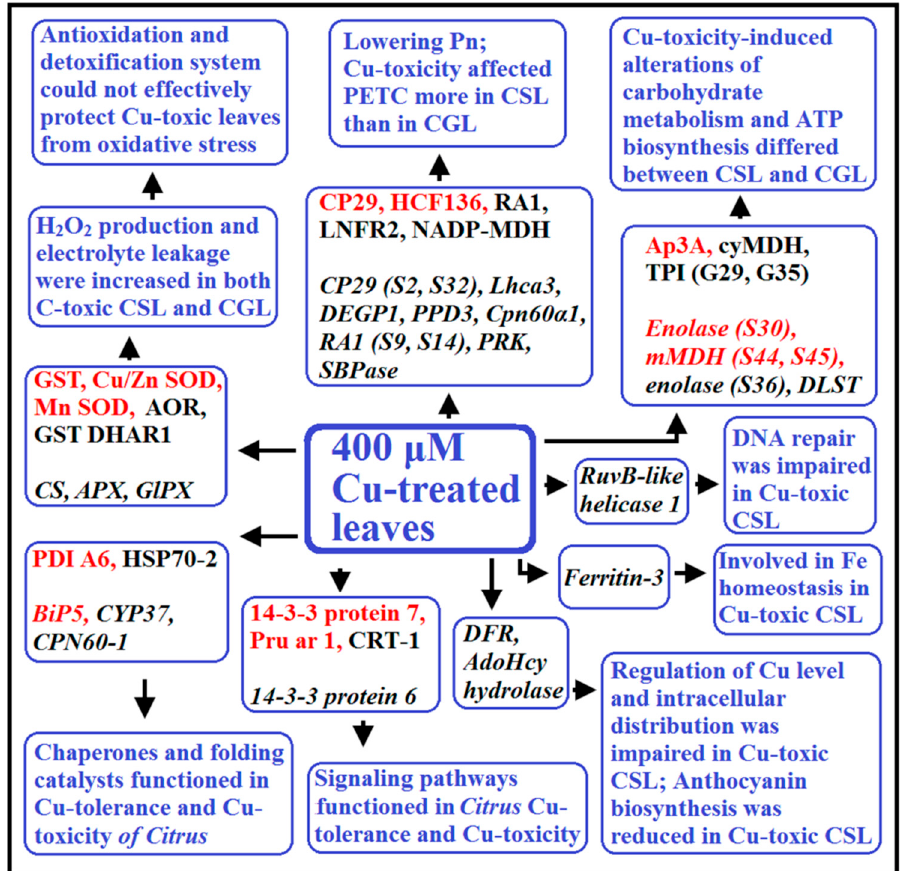
Figure 5. A possible model displaying the di ff erentially abundant proteins (DAPs) in 400 µ M Cu-treated Citrus grandis leaves (CGL) and Citrus sinensis leaves (CSL). In this Figure, plain format and italics were used for Cu-toxic CGL and CSL, respectively. Red: DAPs increased in abundance; Black: DAPs decreased in abundances; APX, L-ascorbate peroxidase; DLST: dihydrolipoyllysine-residue succinyltransferase component of 2-oxoglutarate dehydrogenase complex 2; GlPX: glutathione peroxidase; Pn: photosynthesis; RA1: Rubisco activase A1. Supplementary Materials: The following are available online at http: // www.mdpi.com / 2223-7747 / 9 / 3 / 291 / s1, Figure S1: Excess Cu e ff ects on growth of Citrus grandis (A) and Citrus sinensis (B), Figure S2: Excess Cu e ff ects on root (A), stem (B), leaf (C) and whole plant (D) dry weight (DW) in Citrus grandis and Citrus sinensis seedlings, Figure S3: 2-DE images of proteins extracted from 0.5 (A, E, I, M), 200 (B, F, J, N) 300 (C, G, K, O) and 400 (D, H, L, P) Cu-treated Citrus grandis (A-D and I-L) and Citrus sinensis (E-H and M-P) leaves for the other two replicates, Figure S4: Close-up views of 24 DAP spots in 200, 300 and 400 µ M Cu-treated Citrus sinensis and Citrus grandis leaves, Figure S5: Venn diagram analysis of Cu-responsive proteins in Citrus grandis and Citrus sinensis leaves, Figure S6: Significantly enriched (A-E and H) and the most enriched (F-G) KEGG pathways for annotated di ff erentially abundant proteins (DAPs) in Cu-treated Citrus grandis (A-D) and Citrus sinensis (E-H) leaves, Figure S7: Matrices of Pearson correlation coe ffi cients for di ff erentially abundant proteins (DAPs) in Citrus grandis (A) and Citrus sinensis (B) leaves, Figure S8: Relative expression levels of genes encoding 22 di ff erentially abundant proteins (DAPs) identified in 400 µ M Cu-treated Citrus grandis (G3, G9, G10, G11, G14, G26, G29, G33, G34 and G35) and Citrus sinensis (S2, S5, S9, S16, S17, S23, S24, S30, S32, S33, S37 and S43) leaves using PRPF31 (A) and actin (B) as internal standards, Table S1: Master list of proteins identified in MALDI TOF / TOF MS from 200, 300 and or 400 µ M Cu-treated Citrus sinensis and Citrus grandis leaves using 2DE and DIGE experiments, Table S2: Principal component analysis (PCA) for copper-responsive proteins in Citrus sinensis leaves, Table S3: Principal component analysis (PCA) for copper-responsive proteins in Citrus grandis leaves, Table S4: Specific primer pairs used for qRT-PCR analysis.